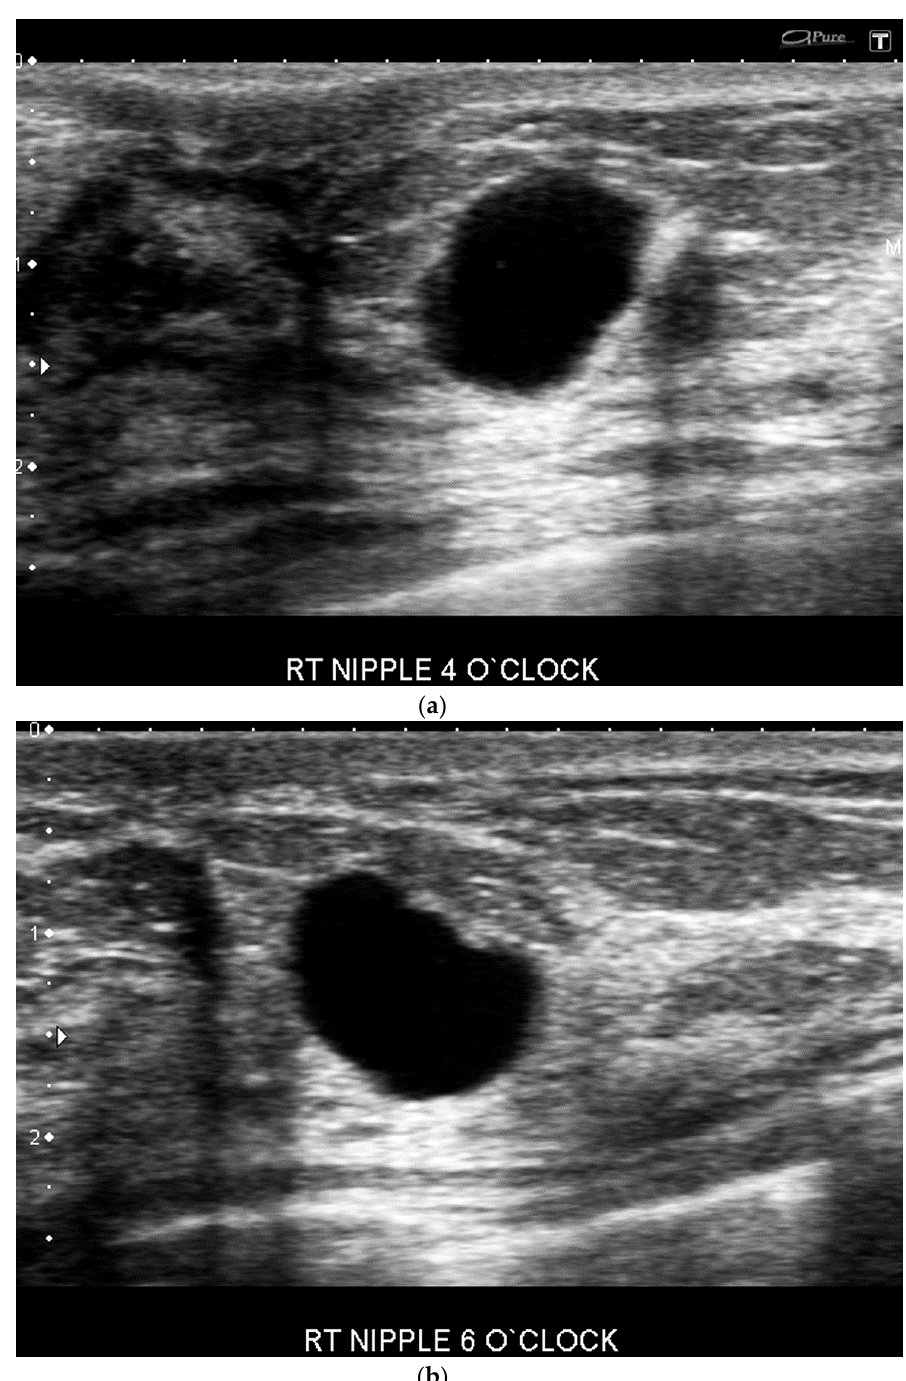
Figure 3. Different locations of a same retroareolar lesion depending on the breast imager. A retroareolar simple cyst is labeled sonographically at 4 o’clock by one breast imager ( a ) and 6 o’clock ( b ) by another one.